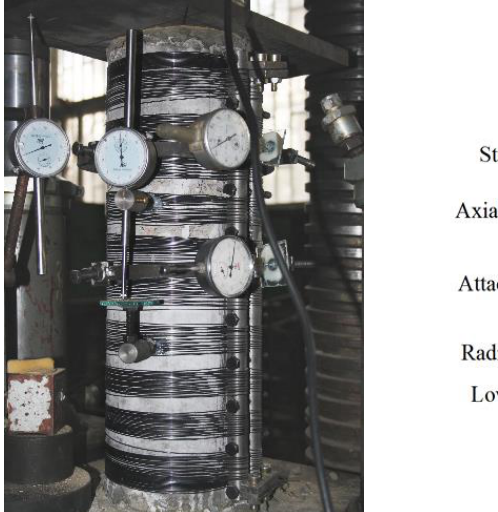
Figure 4. Axial compression test device and structure diagram.